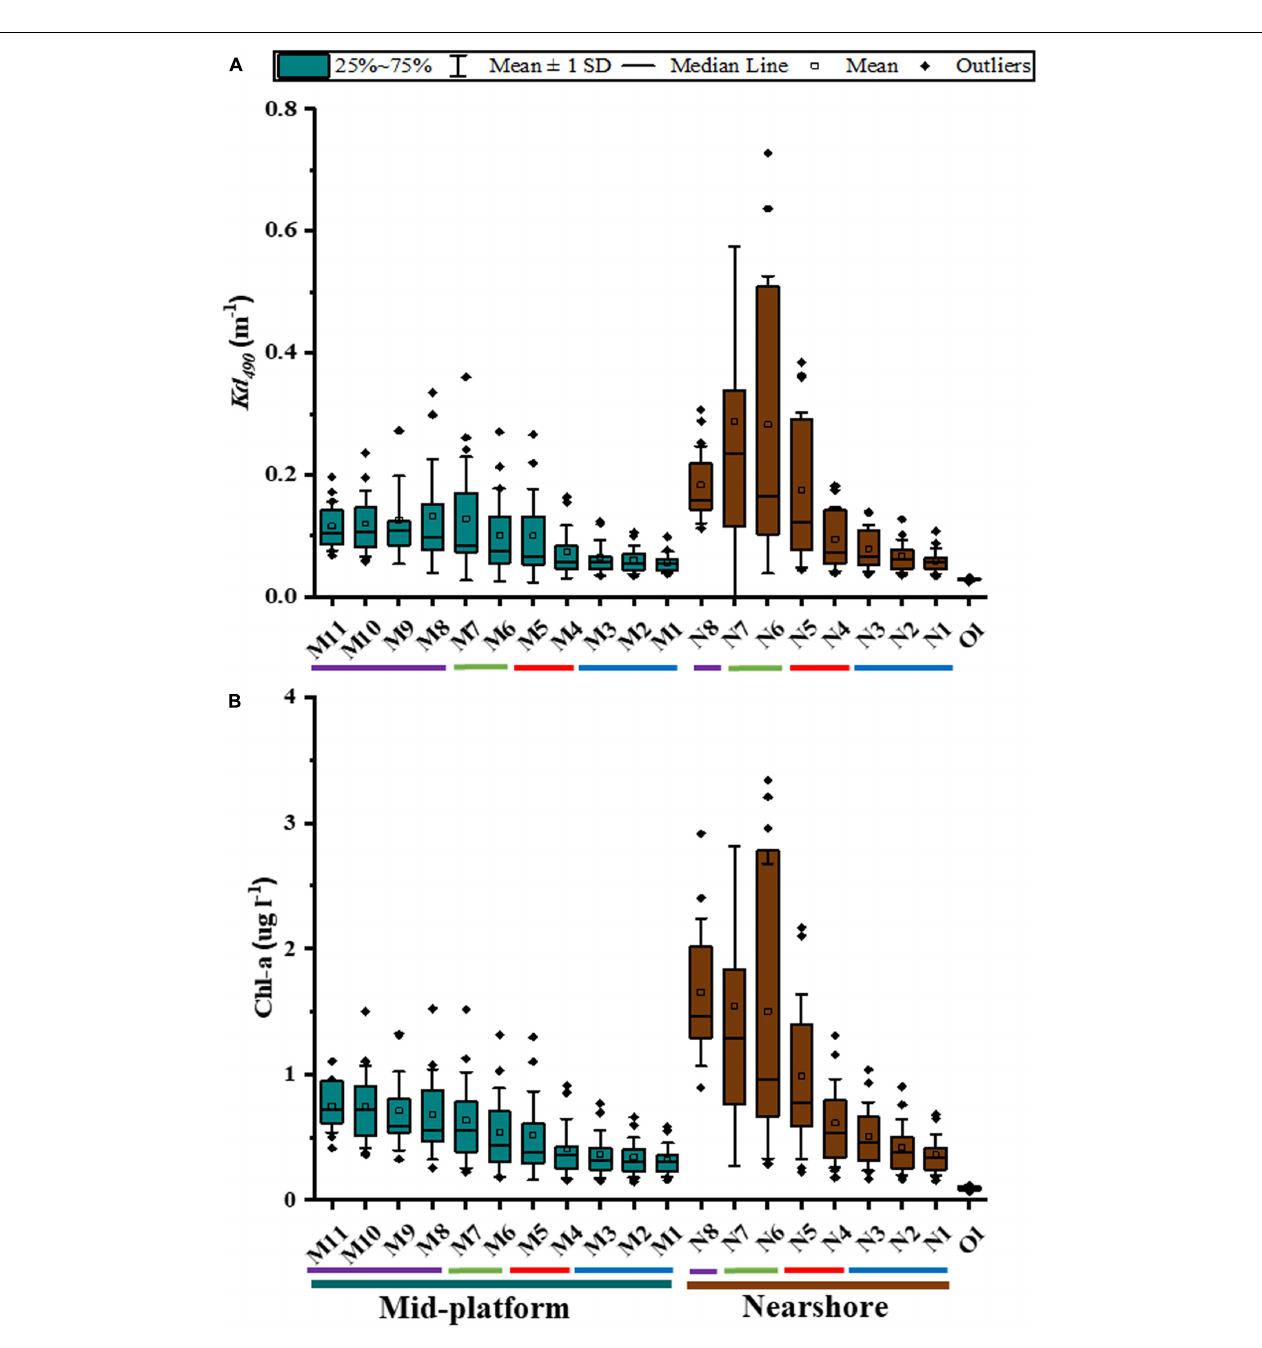
FIGURE 3 | (A) Vertical attenuation coefficient ( Kd 490 ) and, (B) chlorophyll-a concentration estimated with VIIRS data for pixels (virtual stations) located immediately north of the study sites (January 2012–June 2019). Names for virtual stations are based on the same nomenclature used in Figure 1 . X -axis: Blue bar, mid-platform virtual stations (M1–11); Brown bar, nearshore virtual stations (N1–8); O1, 25 km offshore virtual station.